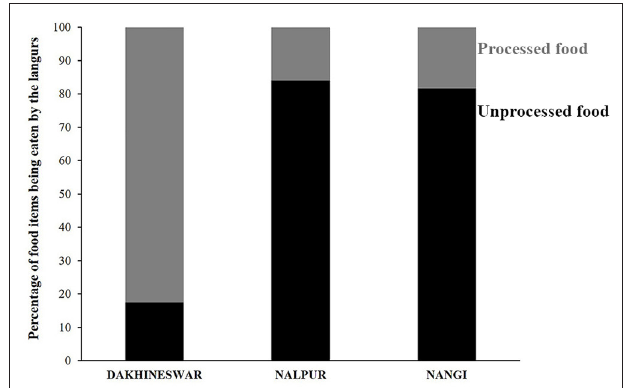
FIGURE 1 | Stacked bar diagram showing the feeding habit of free-ranging langurs at three locations, Dakshineswar, Nalpur, and Nangi. Black and gray bars represent the percentage of “unprocessed” and “processed” food items being eaten by the free-ranging langurs.